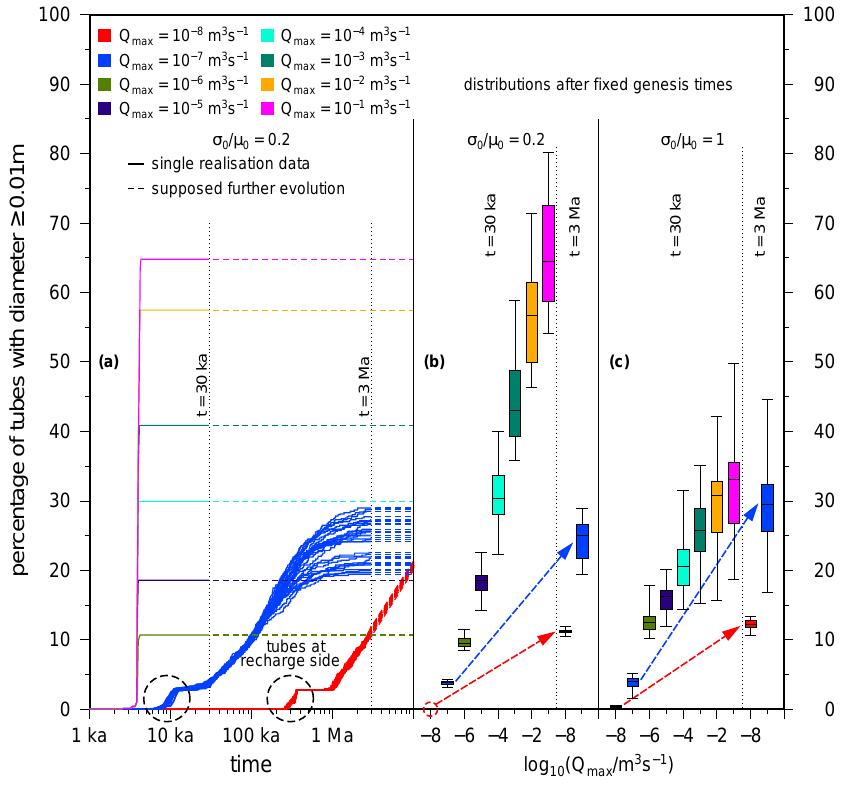
Fig. 11. Overview of the percentage of large-aperture tubes with a ≥ 0 . 01m evolving in simulations with different initial heterogeneity and different maximum recharge rates. The left panel (a) shows the temporal evolution in a network with low initial heterogeneity for one realisation with Q max ≥ 10 − 6 m 3 s − 1 (until 30ka) and for all realisations with Q max ≤ 10 − 7 m 3 s − 1 (suppressed flow scenarios; until 3Ma), respectively. Dashed lines represent the supposed further development of the individual realisations until 10Ma of karstification. The panels (b) and (c) illustrate results for both degrees of intial heterogeneity after 30ka excluding realisations in which nary a tube reached an aperture width of a ≥ 0 . 01m. The corresponding long-term results for suppressed flow scenarios after 3Ma are marked with